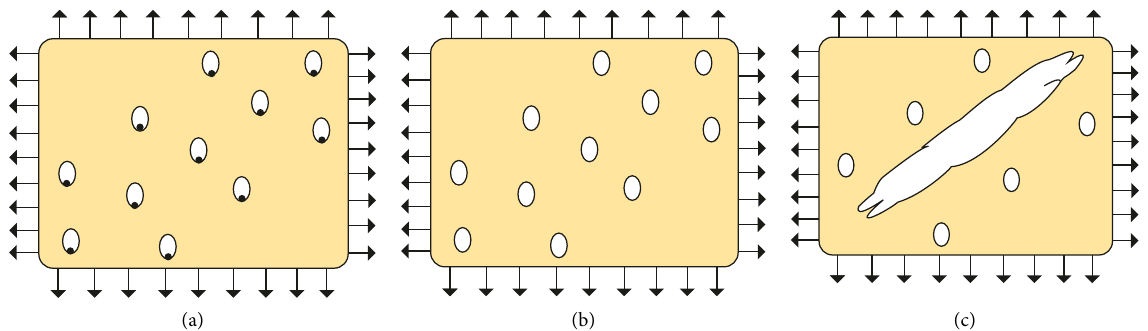
Figure 12: Fracture mechanism of steel. (a) The formation of micropores. (b) The deformation of micropores. (c) The cut-through of